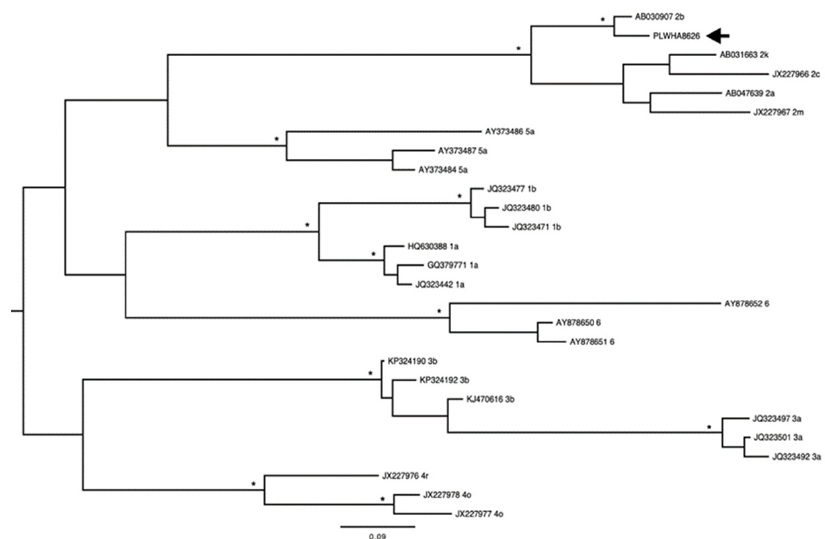
Figure 2. Maximum likelihood phylogenetic tree of hepatitis C virus (HCV) nucleotide sequences (from non-structural region 5B gene (313 nt)) isolated in a person living with HIV/AIDS in the Brazilian city of Belém, Amazon region, with other sequences of this hepatotropic virus deposited on GenBank. The tree was rooted at the midpoint. The asterisks point to key nodes with high support (SH-aLRT scores ≥ 0.90). The sample of this study can be identified by the acronym PLWH + number and is h (the arrow is to identify the analyzed area).